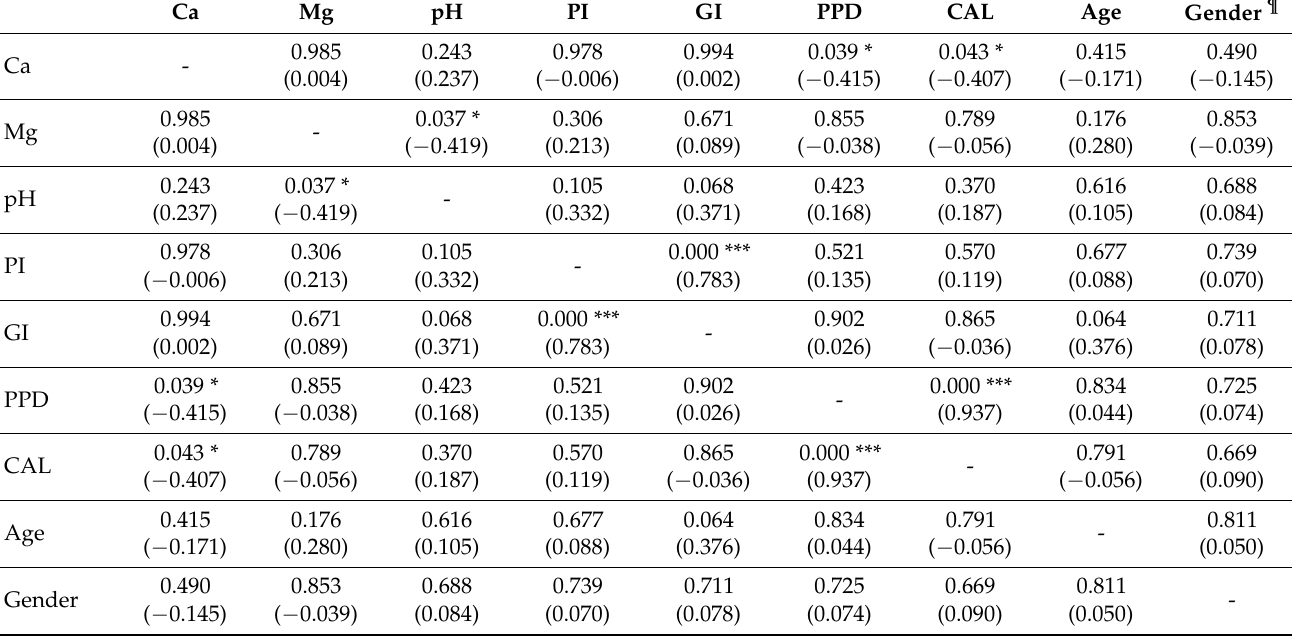
Table 4. Correlation analysis of parameters in Group I.